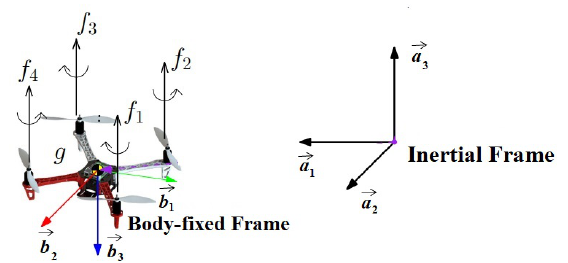
Figure 6. Quadrotor inertial and body-fixed frames.